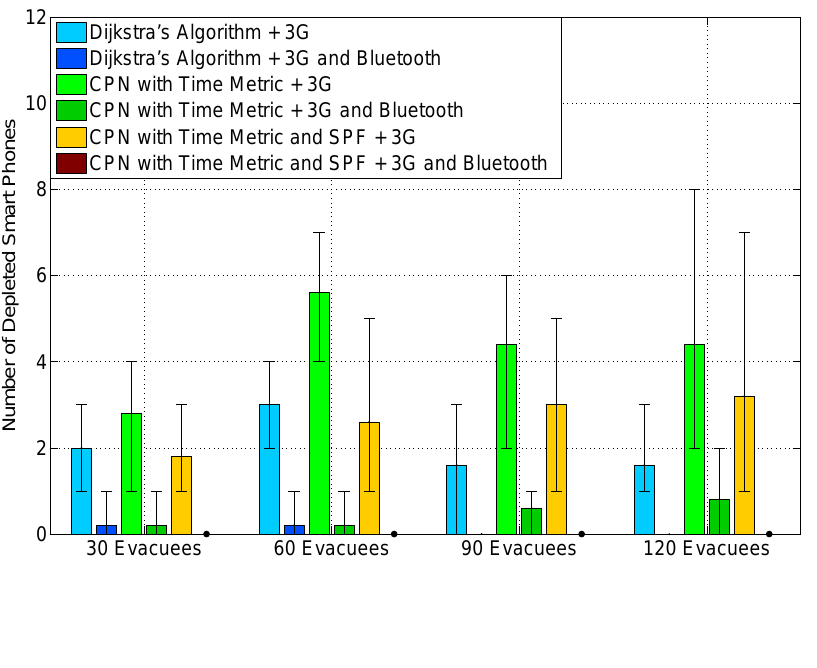
Figure 4. The number of drained smart phones for five iterations. The error bars represent the min/max values found in the five simulations. Please note that the bar for “CPN with Time Metric and SPF + 3G and Bluetooth” is not displayed, because there is no drained smart phone in this case.